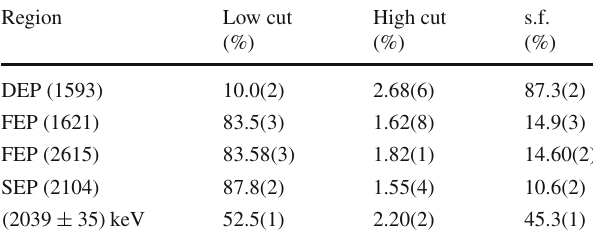
Table 11 Rejected event fractions by the low and high A/E cuts, and the survival fractions (s.f.) from all BEGe detectors and